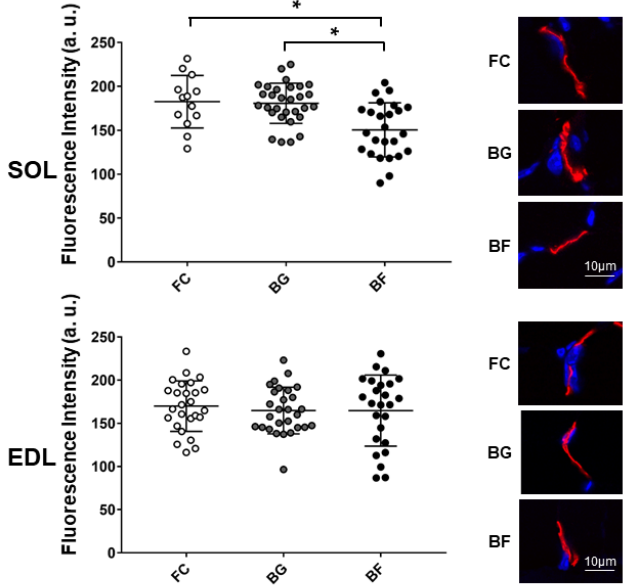
Figure 3. Confocal fluorescence intensity analysis of junctional nAChRs in SOL and EDL muscles of Bion-M1 flown (BF) vs. two Bion-M1 ground controls mice (FC, BG). A significant decrease in pixel fluorescence intensity was measured in SOL muscle ( upper panel ) of Bion-M1 flown mice (BF vs. BG, p ≤ 0.001; BF vs. FC, p ≤ 0.004) but not of EDL muscle ( lower panel ) (BF vs. BG, p ≤ 0.8929; BF vs. FC, p ≤ 0.6051) compared to the BG and FC muscle controls. Upper ( SOL ) and lower ( EDL ) graph, representative images of α -BTX stained nAChRs in BG, BF, and FC groups. No differences were observed between BG and FC control muscles. Data are expressed as means ± SE. For each experimental group n = 2 male C57BL/N6 mice (19–20 weeks old). Statistical differences between groups were determined by unpaired t -test. * = indicates significant difference vs. CON (ANOVA p <